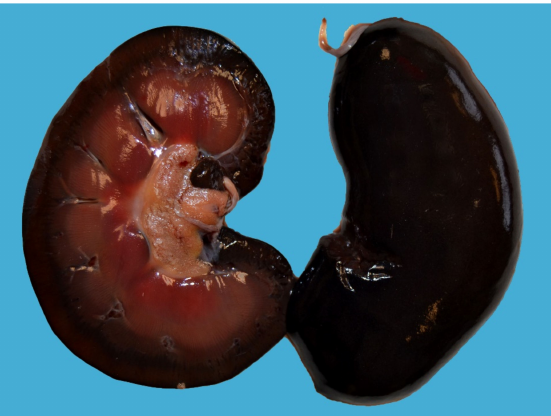
Figure 4. Diffuse dark red to brown discoloration of the renal cortex and medulla in a lamb with